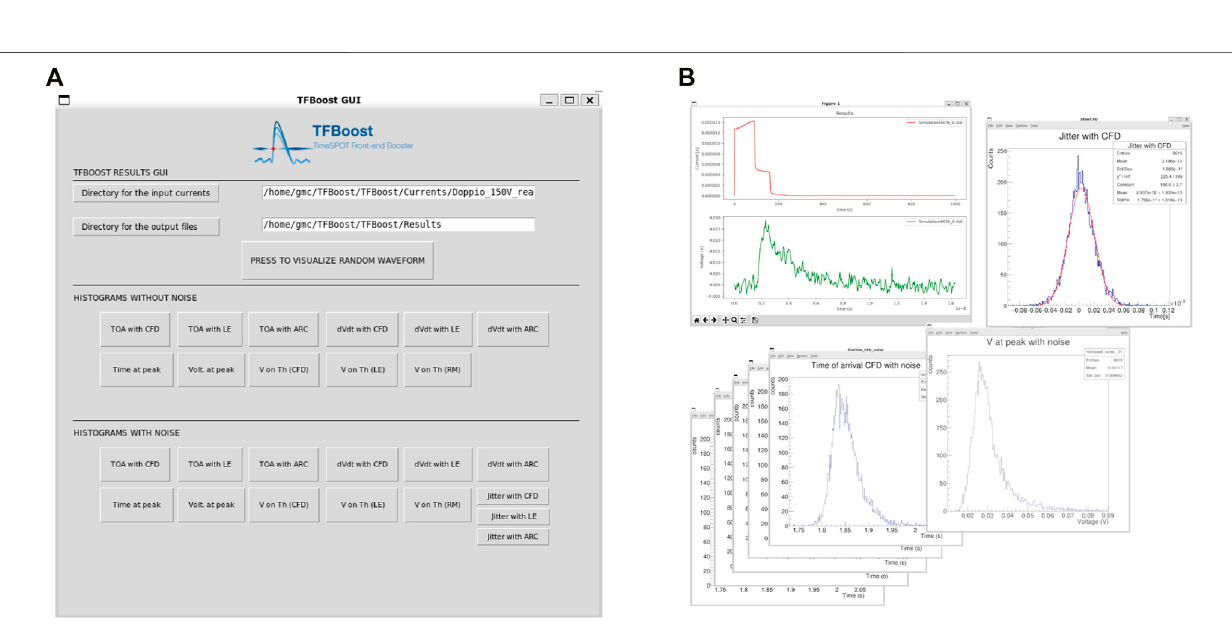
Frontiers in Physics |